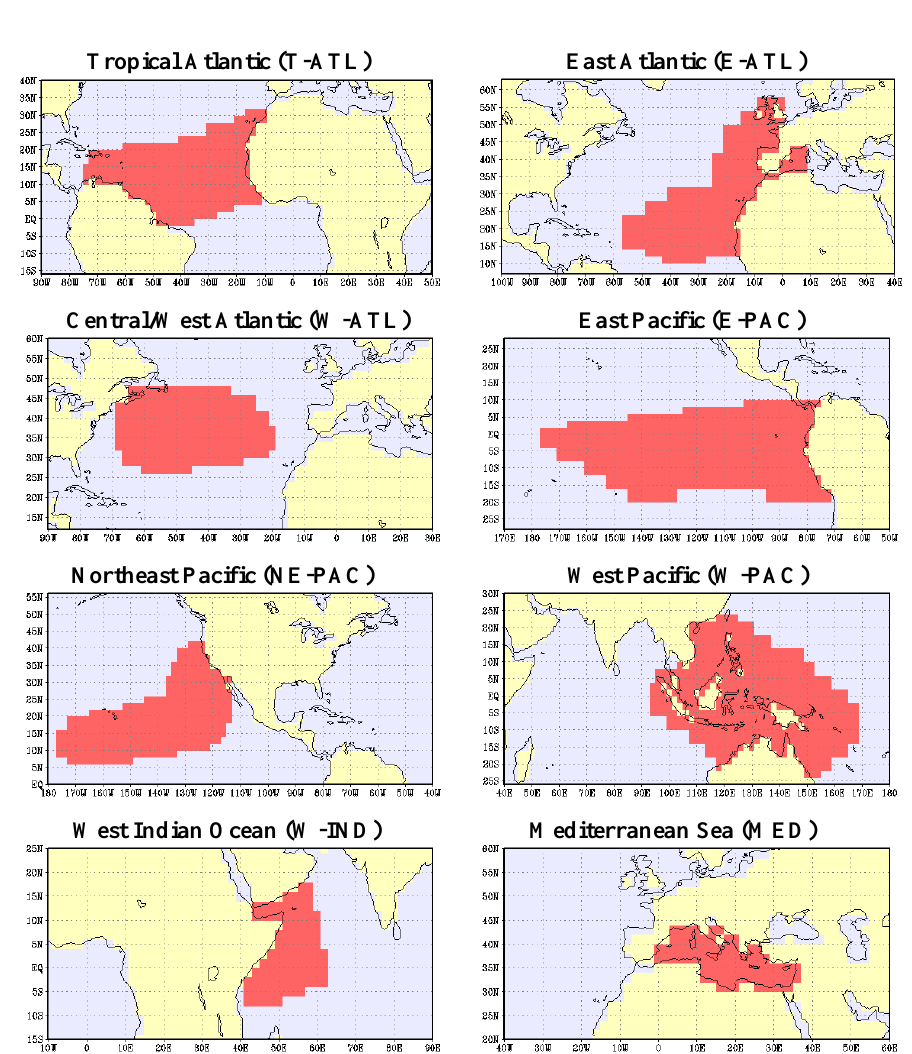
Fig. 13. Spatial representation of the eight oceanic regions considered in this study, with the aim of evaluating the potential influence of SST Figure 13 on the Mediterranean scPDSI fields. Choice of areas was based on Hertig et al.